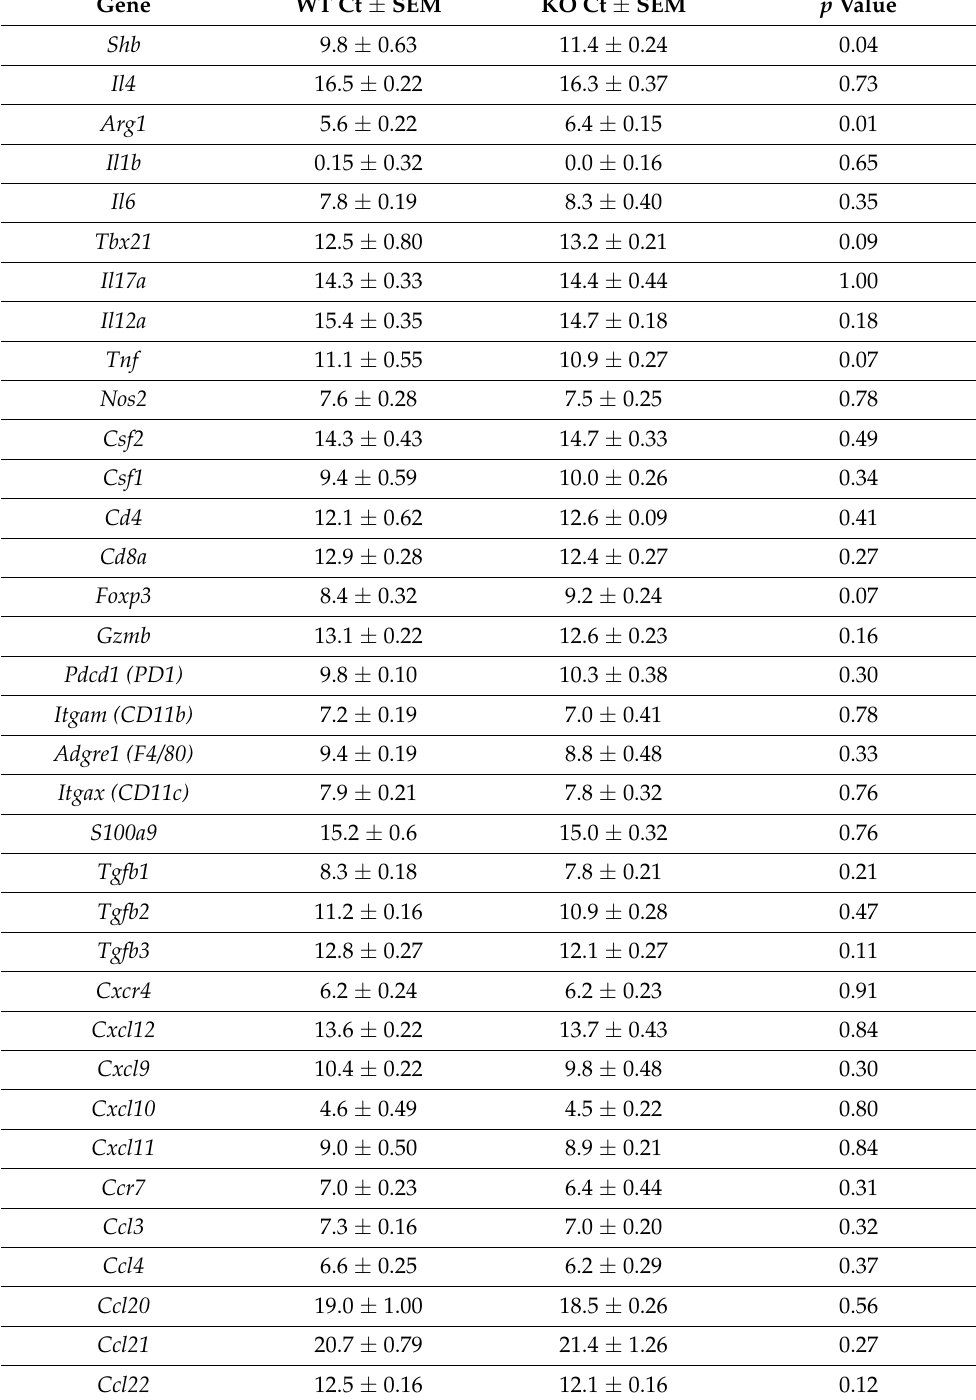
Table 2. Relative gene expression as Ct values in tumor CD45 + cells after subtraction of beta-actin values in wild type (WT) and EC Shb knockout (KO) cells. WT is based on four tumors/mice and KO